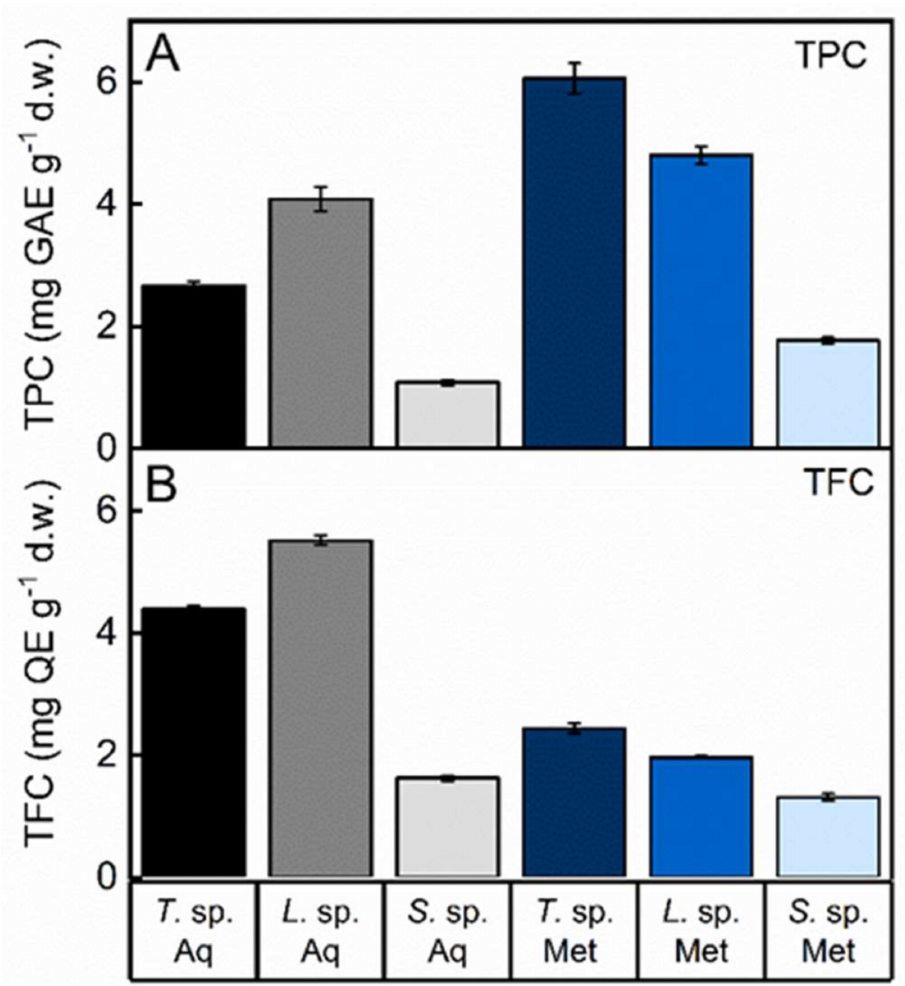
Figure 2. Total phenolic content (TPC) ( A ) and total flavonoid content (TFC) ( B ) of the aqueous (Aq) and methanol (Met) fungal extracts of Trametes sp. S2.OA.C_F6 ( T . sp.), Lenzites sp. S3.OA.B_F6 ( L . sp.) and Sistotrema sp. S1.OA.C_F2 ( S . sp.). TPC was expressed in terms of gallic acid equivalent (GAE) g − 1 dry weight; TFC was expressed as quercetin equivalent (QE) g − 1 dry weight. Data were reported as mean values ± standard deviation (SD) of